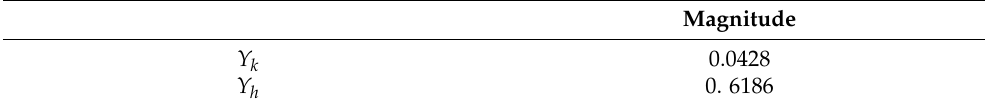
Table 11. Magnitude levels of ideal alternatives.